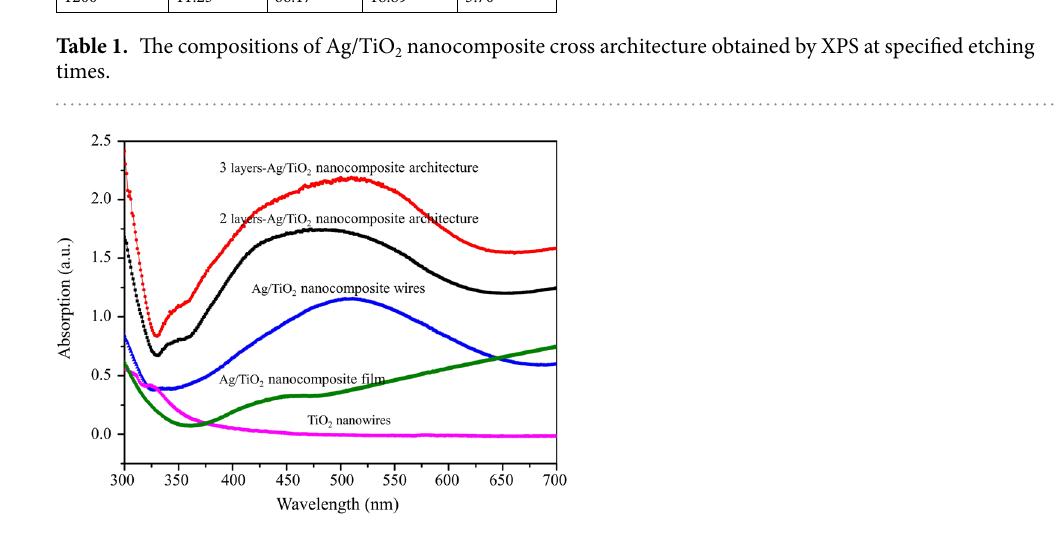
Figure 6. UV-vis absorption measurements of fabricated samples: three-layer Ag/TiO 2 nanocomposites cross architecture, two-layer